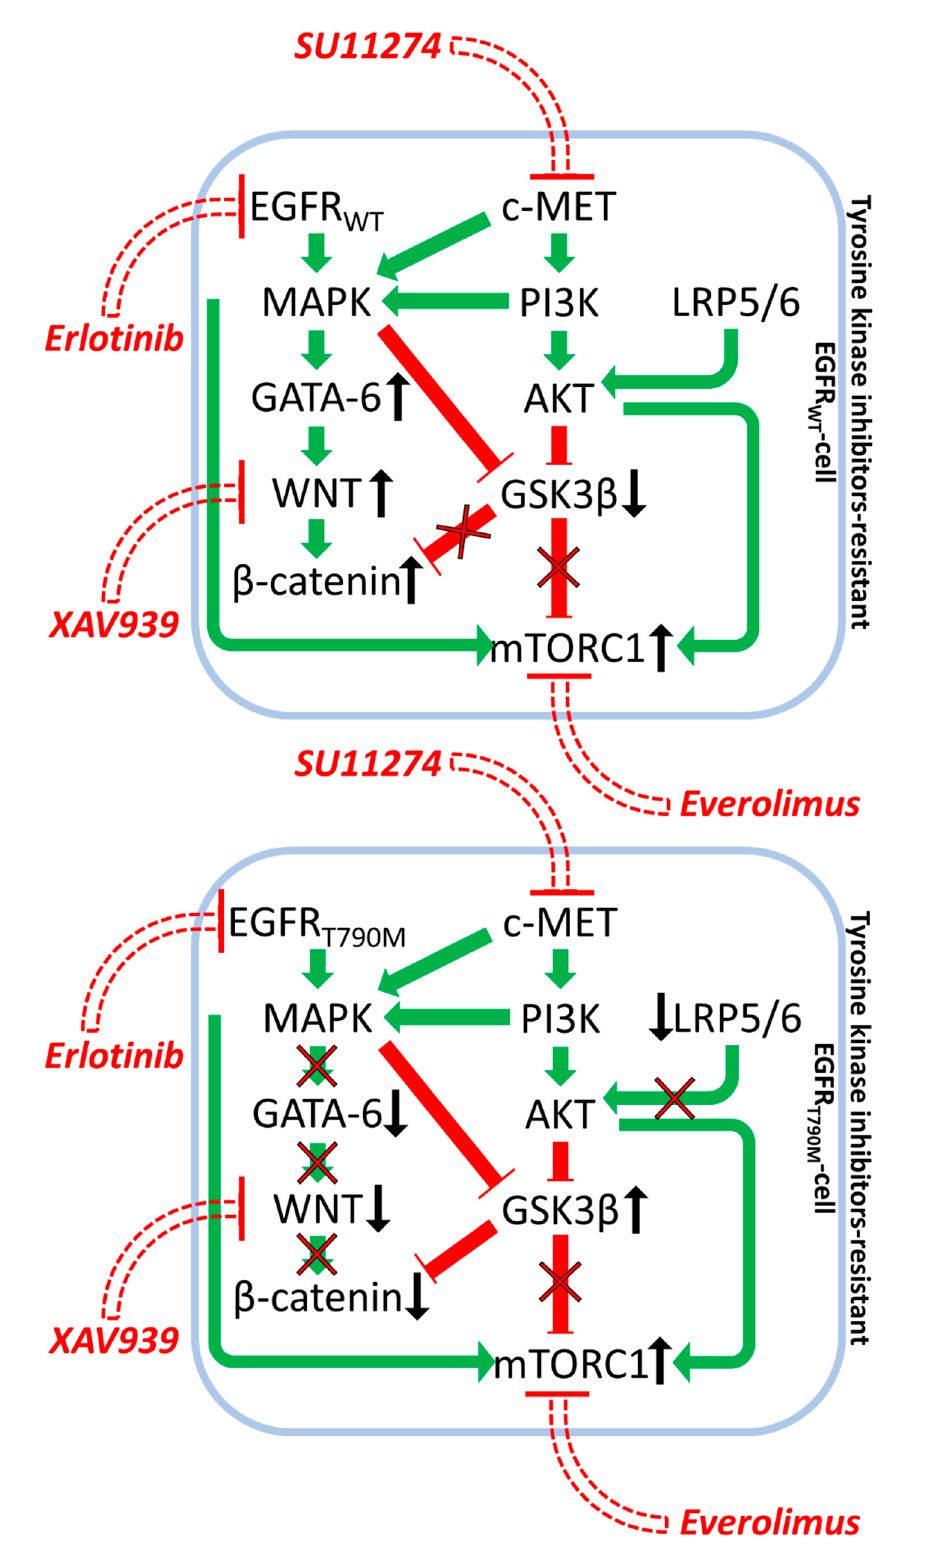
Figure 5. Effects of EGFR, mTORC1 and WNT Inhibitors on Growth Inhibition in Drug Resistance in Non-Small Cell Lung Carcinoma. Green arrows indicate stimulation, blocked red arrows indicate inhibition.